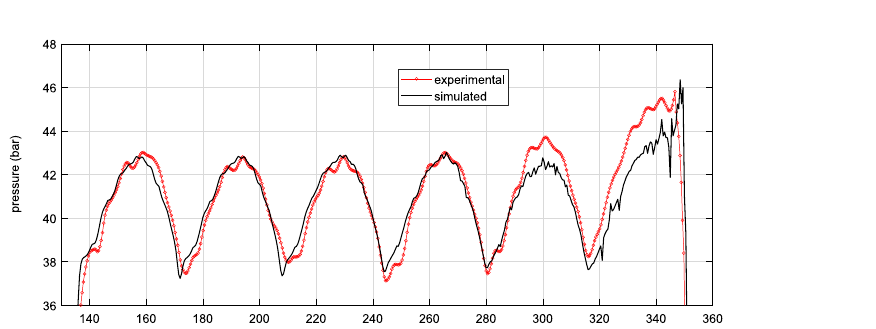
Figure 11. Detail of the pressure with plates A at 750 rpm when the chamber is connected to the delivery volume.